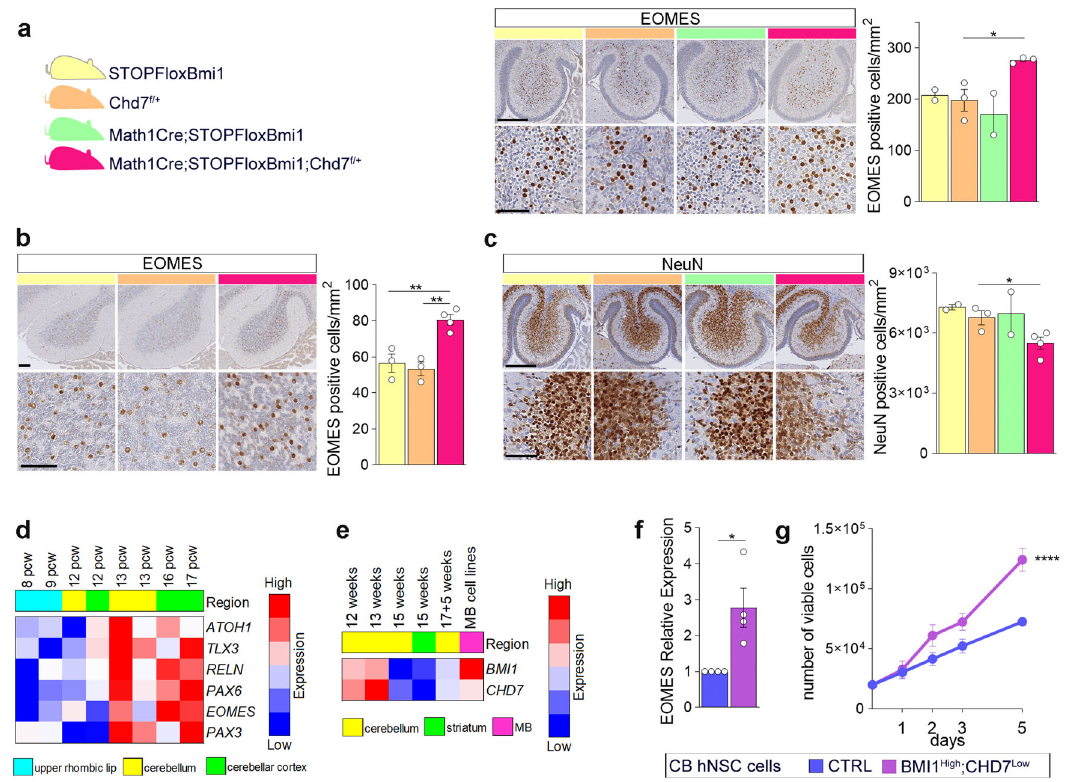
Fig. 1 Increased number of UBC and expression of EOMES upon modelling of the BMI1 High ;CHD7 Low signature in progenitor cells. a , b Colours identify STOPFloxBmi1 (yellow), Chd7 f/ + (orange), Math1Cre;STOPFloxBmi1 (green) or Math1Cre;STOPFloxBmi1;Chd7 f/ + (pink) genotypes throughout the fi gure. EOMES IHC staining and quanti fi cation of UBC in the cerebellum at P7 ( a ) or P21 ( b ) developmental stages. a n = 2 biological independent animals per STOPFloxBmi1 and Math1Cre;STOPFloxBmi1 genotypes, n = 3 biological independent animals per Chd7 f/ + and Math1Cre;STOPFloxBmi1;Chd7 f/ + genotypes. b n = 3 biological independent animals per STOPFloxBmi1 and Chd7 f/ + genotypes, n = 4 biological independent animals per Math1Cre;STOPFloxBmi1;Chd7 f/ + genotype. One-way ANOVA. c NeuN IHC staining and quanti fi cation of GC in the cerebellum at P7. n = 2 biological independent animals per STOPFloxBmi1 and Math1Cre;STOPFloxBmi1 genotypes, n = 3 biological independent animals per Chd7 f/ + genotype, n = 4 biological independent animals per Math1Cre; STOPFloxBmi1;Chd7 f/ + genotype, one-way ANOVA. d Heatmap showing z-scores of UBC marker expression in the human upper rhombic lip (light blue), cerebellum (yellow) and cerebellar cortex (green) from 8 to 17 pcw. e Heatmap showing relative expression of BMI1 and CHD7 in a collection of hNCS lines isolated from the cerebellum (yellow) or striatum (green) as compared to MB cell lines (pink). f qPCR analysis of EOMES expression level in hNSC upon CHD7 silencing (BMI1 High ;CHD7 Low , purple) compared to control (CTRL, violet). n = 4 biologically independent experiments, two-tailed unpaired t test. g Cell proliferation assay of CDH7-silenced or control cells. n = 6 biologically independent experiments, two-way ANOVA. All graphs report mean±SEM. P values: * P <0.05, ** P <0.01 or **** P < 0.0001. Scale bars = 100 µ m. Source data are provided as a Source Data fi